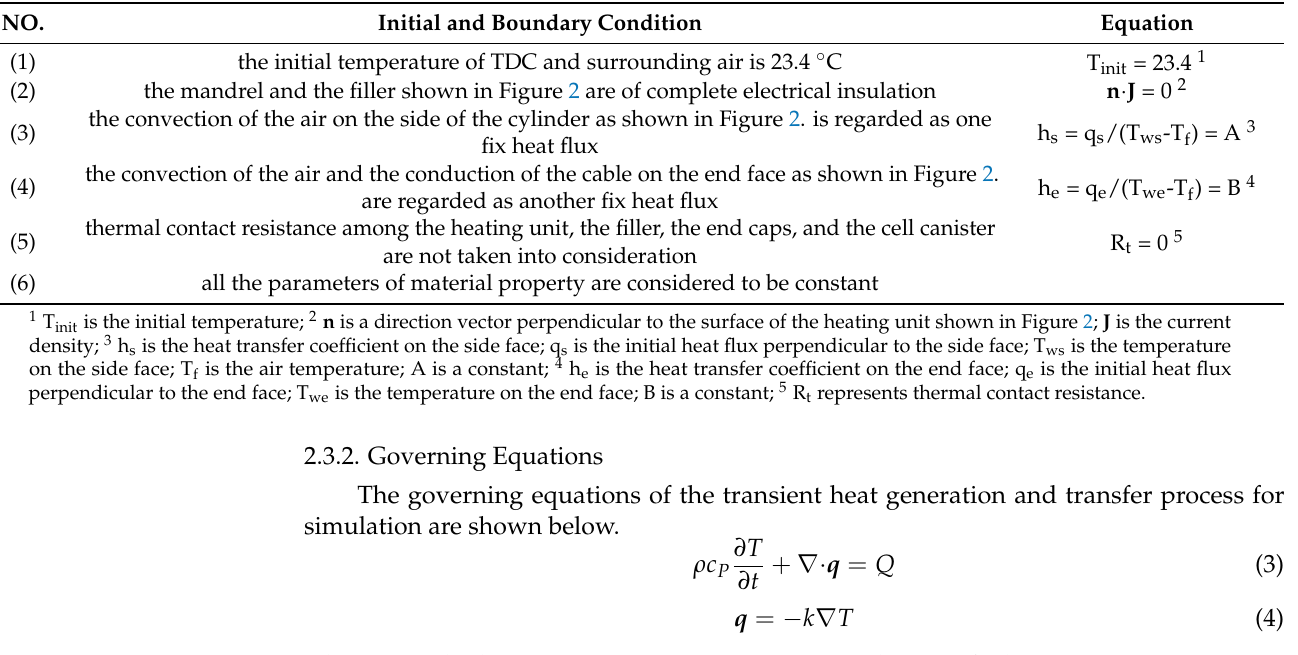
Table 2. Initial and boundary conditions for